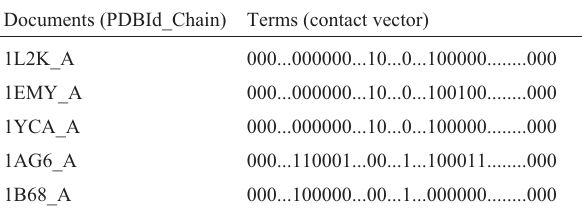
Table 1 - Sample dataset consisting of five different proteins. The first three proteins are myoglobins and the remaining are proteins from differ- ent